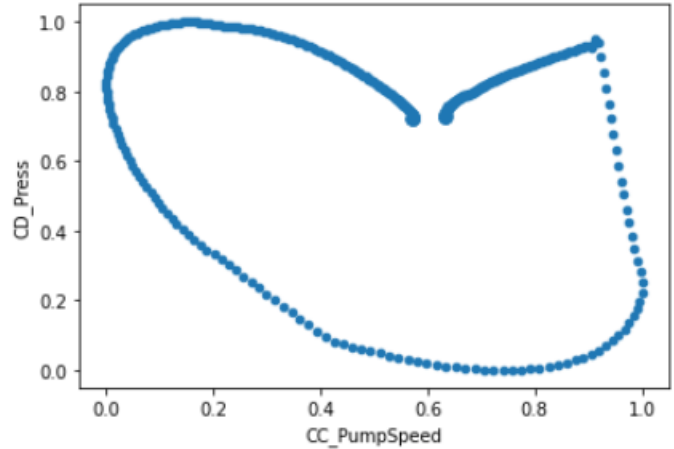
Figure 34. CC_PumpSpeed and CD_Press Data—scatter